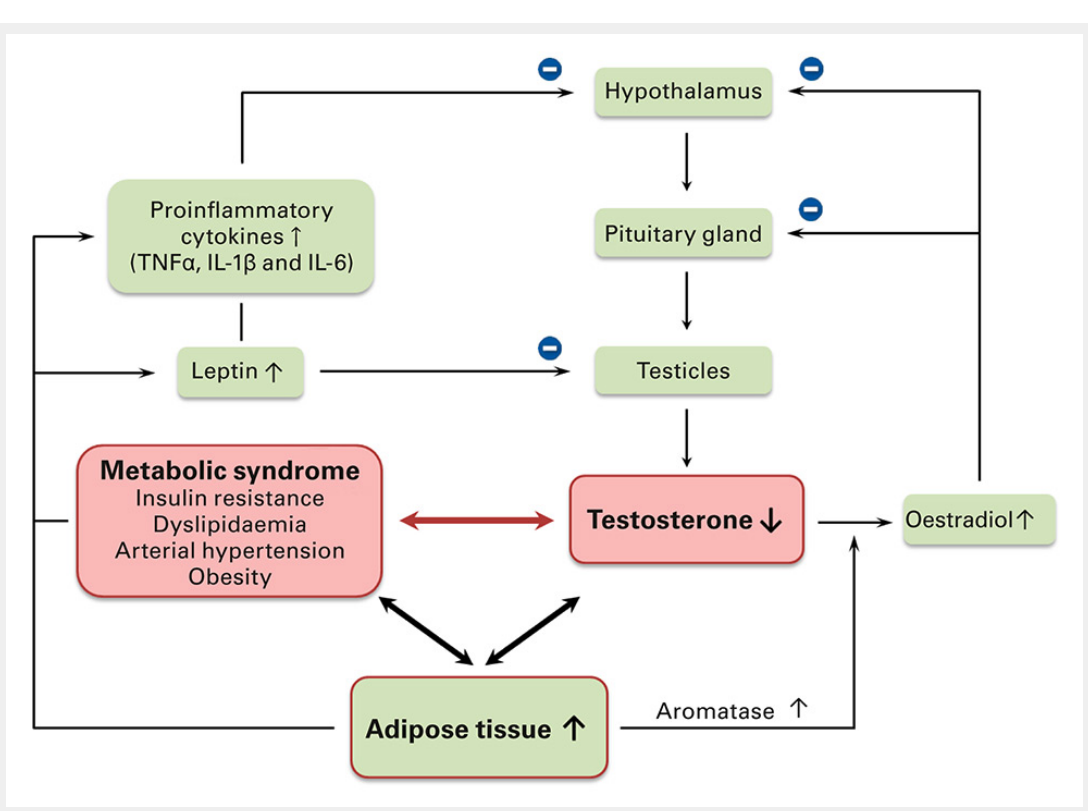
Figure 1 Pathophysiological interplay between adverse metabolic parameters, adipose tissue and testosterone deficiency. Adipose tissue as a pivotal component of the pathophysiological interplay leads to increased release of inflammatory mediators (TNF-α, IL-1β and IL-6) and leptin which cause dysfunctions of the hypothalamic-pituitary-testicular axis and result in decreased testosterone production. Increased activity of aromatase in adipose tissue enhances the conversion of testosterone to oestradiol which exerts negative feedback effects on both hypothalamus and pituitary gland. Consecutive testosterone deficiency promotes an increase in fat mass and worsening of metabolic surrogate parameters, demonstrating the bidirectional relationship. TNF-α = tumour necrosis factor α; IL-1β = interleukin 1β; IL-6 = interleukin